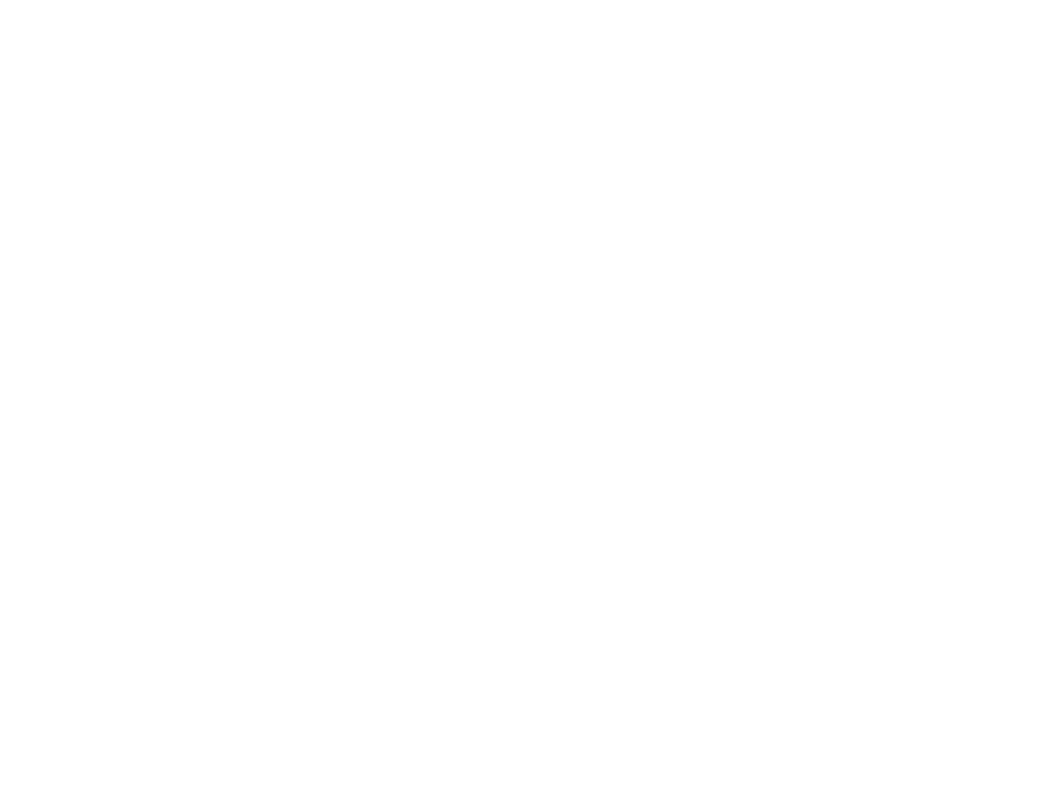
Table 5. Texture analysis of kernels for selected air stream velocities (25 m s −1 ) and the position of the seed- air tube type I. a–e: the differences between mean values with the same letter in columns were statistically insignificant ( p <